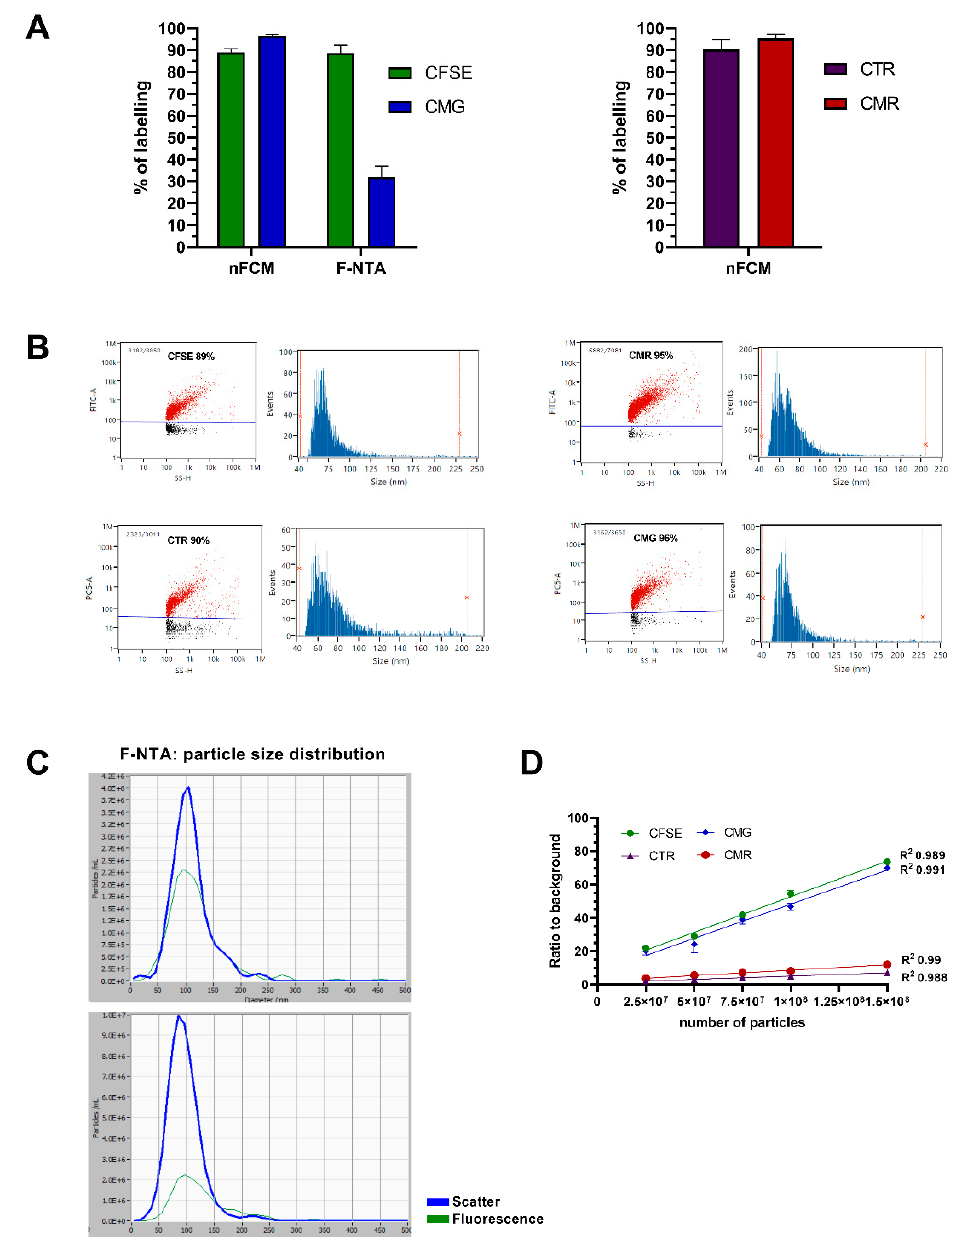
Figure 1. Fluorescence measurements on nFCM, F-NTA and plate reader after sEV staining with membrane and cytoplasmic dyes. ( A ) HT29 sEVs were stained with membrane-specific (CMG or CMR) or cytoplasmic dyes (CFSE or CTR) and analyzed on nFCM and F-NTA to evaluate labeling %. Data is presented as mean ± SEM of at least three independent experiments (except for nFCM- CMG and CMR, and F-NTA-CFSE, which were repeated twice). ( B ) Representative nFCM dot-plots and PSD histograms, and ( C ) histograms obtained after analyzing EVs by F-NTA in scatter and fluorescence mode. ( D ) Bulk fluorescence intensity of a dilution series of stained HT29 EVs was measured by plate reader. Signal over background (PBS) ratios are represented and trendlines drawn for the assessment of correlations. Additional data from procedural controls is provided in Supplementary Figure S1.